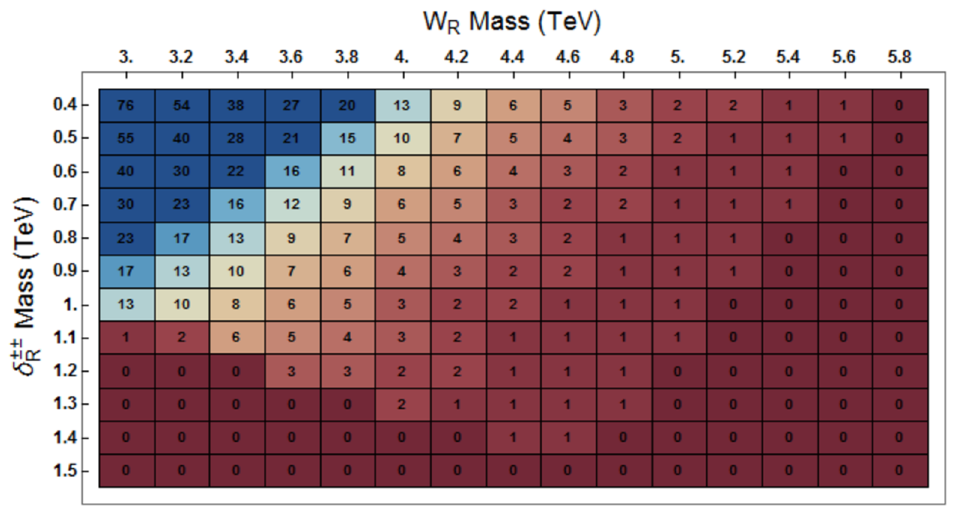
Figure 7. Maximal number of detected events by the Higgs mediated channel for ( M W mass coordinates in a two-dimensional mass plane area (for an integrated luminosity of 300 fb − 1 . The efficiency is given in table